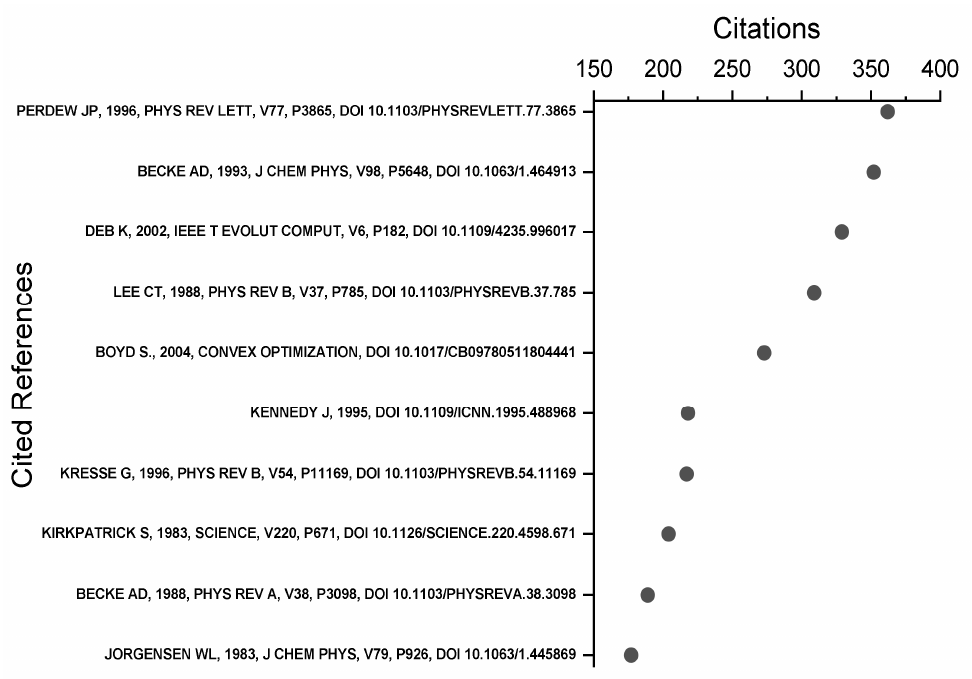
Figure 10. Most top ten locally cited papers [31–40].